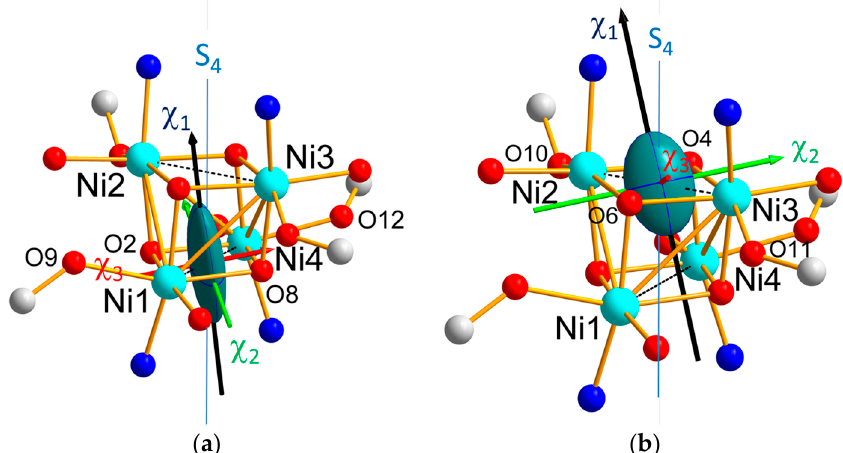
Figure 8. Magnetic ellipsoids associated to the antiferromagnetic pairs: ( a ) Ni1–Ni4; and ( b ) Ni2–Ni3. The easy magnetic axes are represented in black, the mean axes in green and hard axes in red.